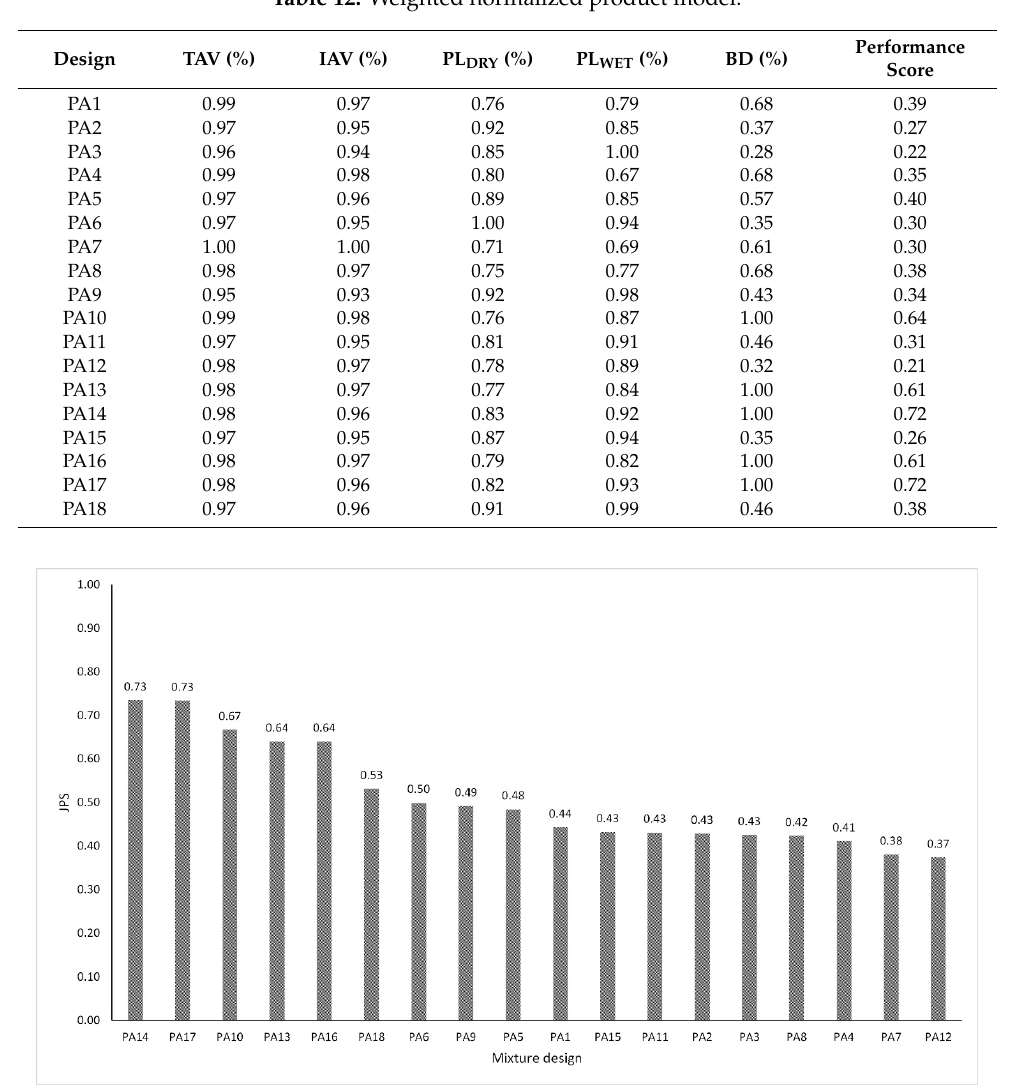
Figure 14. Joint Performance Score (JPS) values and preference ranking according to the WASPAS method.